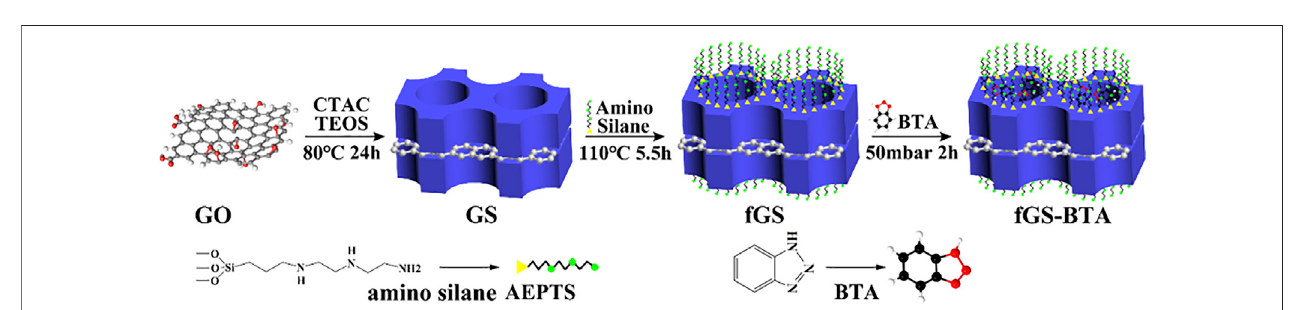
FIGURE 15 | Illustration of the synthetic processes for fGS-BTA nanosheets (Xiong et al., 2019b).